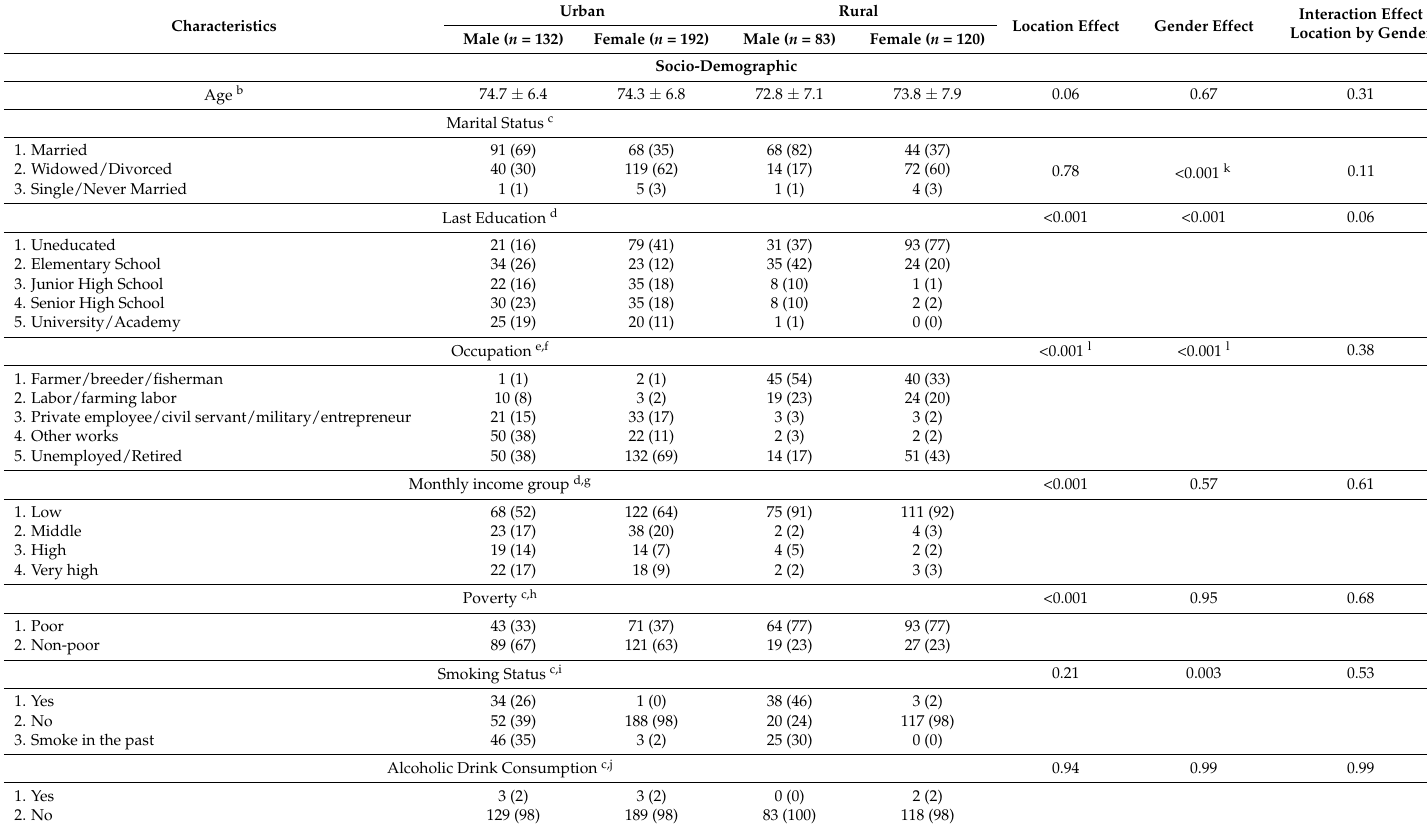
Table 1. Sociodemographic characteristics, self-reported perception of health and medical history of the rural and urban study participants a .